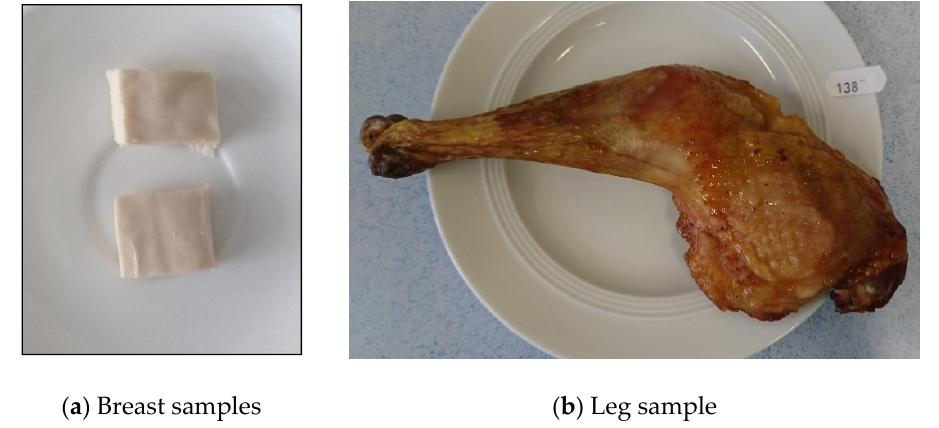
Figure 1. Pictures of ( a ) breast and ( b ) leg samples prepared for sensory evaluation.